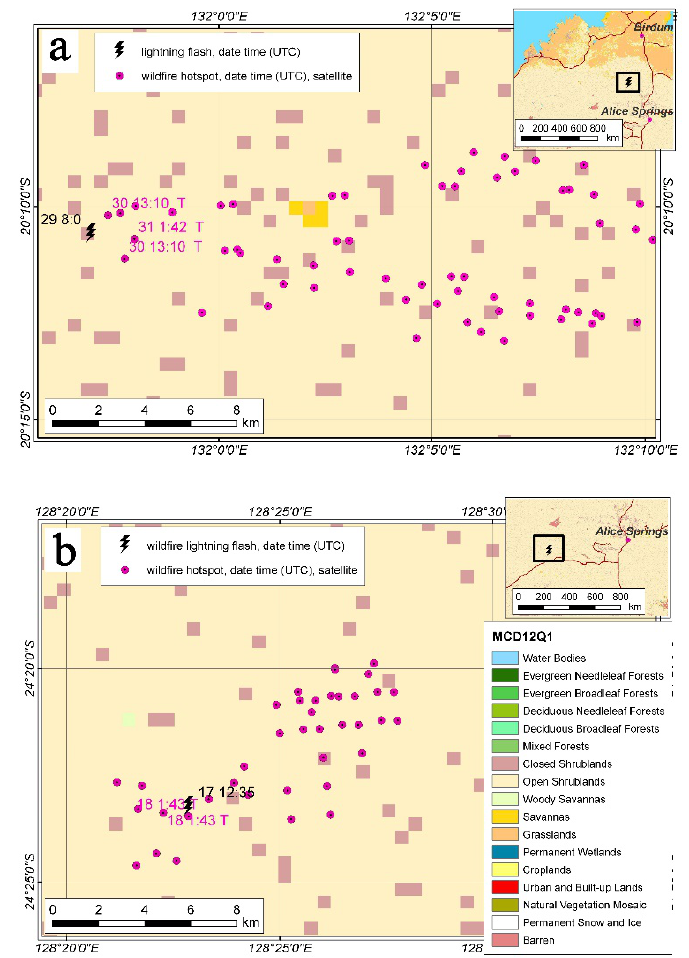
Figure 10. The spatial join distributions of a couple of the lightning flashes and the wildfire hotspots, recorded together by the ISS LIS (black zipper markers) and by the MODIS Terra/Aqua (red points) sensors in the northwestern part of Australia. ( a ) corresponds to the study case on 29 October 2017, and ( b ) on 17 December 2017. In both cases, the weather conditions promoted propagation of the wildfires to the east in the next one to two days. These lightning-caused wildfires have a place in open shrublands. The MODIS land cover map (MCD12Q1, 2018) was used as a background image. Note that severe thunderstorms more often extinguish fires than contribute to